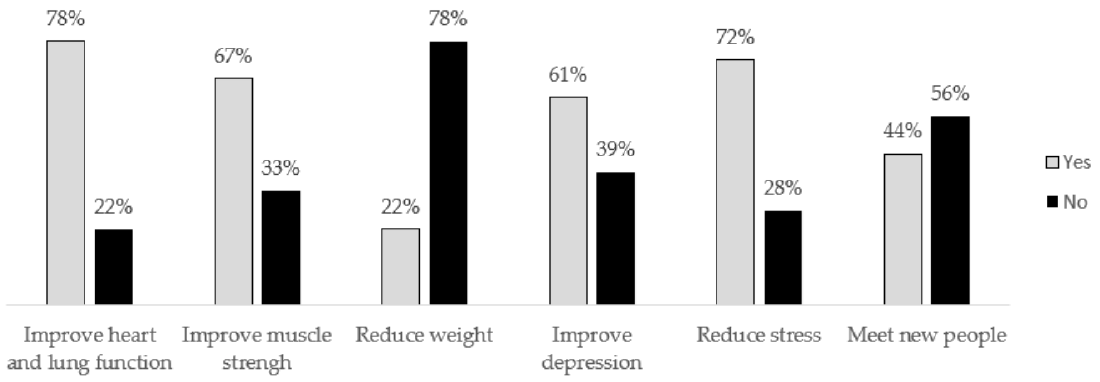
Figure 2. Possible benefits of ET program (n = 18).